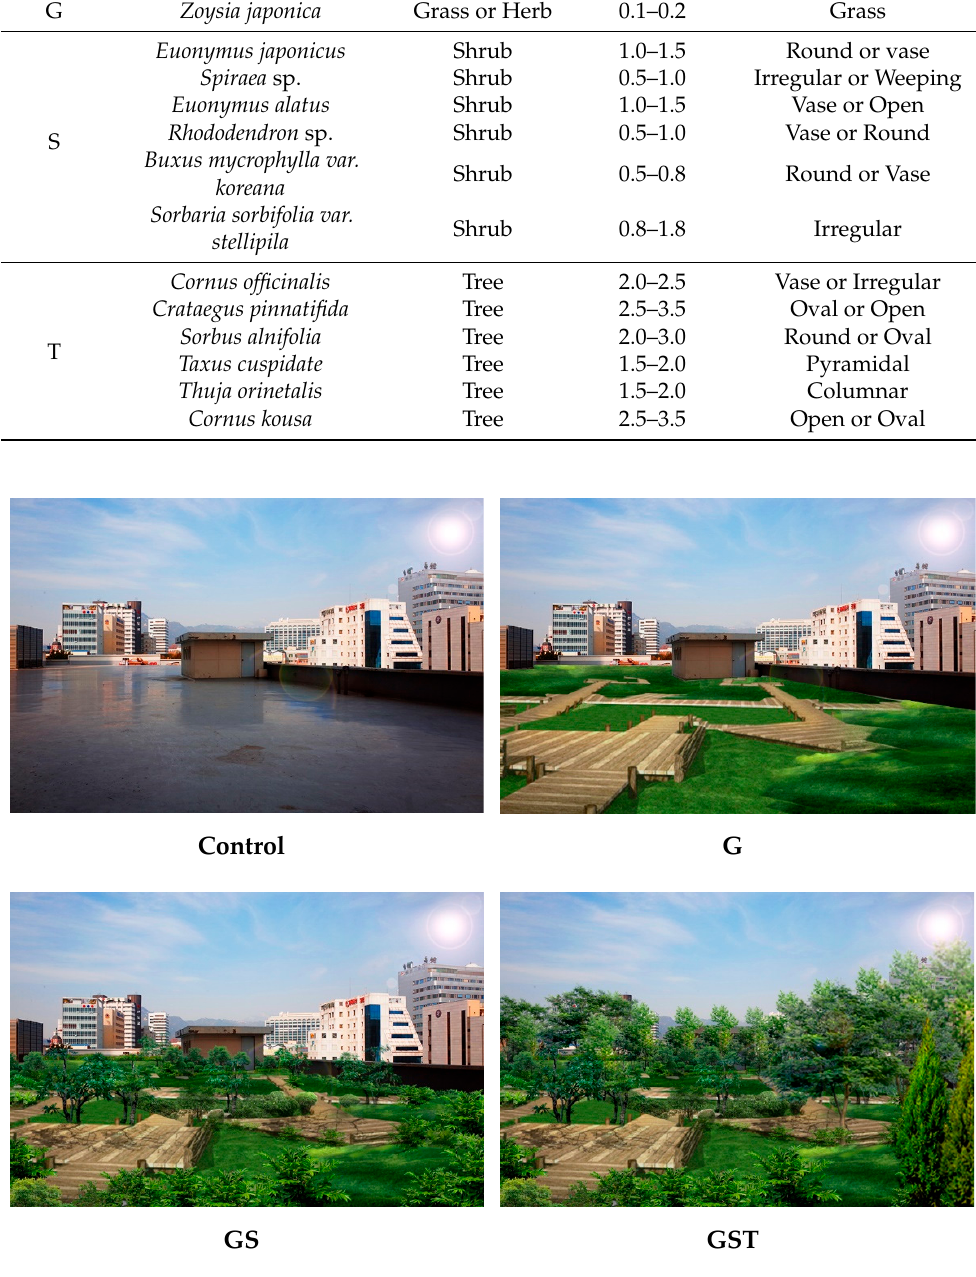
Figure 1. The four types of rooftop landscapes used in this study. Control: no vegetation with concrete floor; type G: grass vegetation; type GS: grass-shrubs vegetation; type GST: grass-shrubs- trees vegetation.